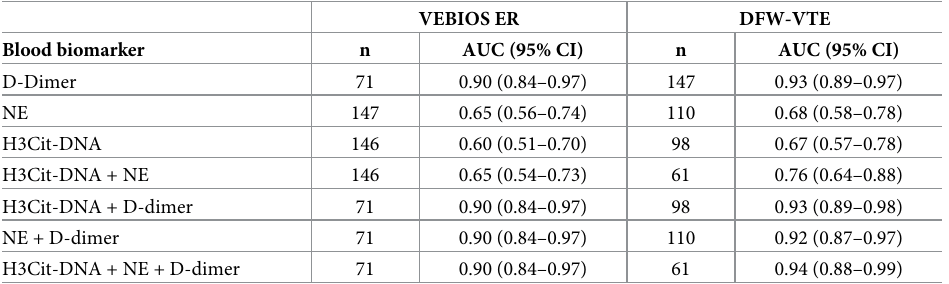
Table 3. Area under receiver operating characteristics curve (AUC) for D-dimer, H3Cit-DNA and